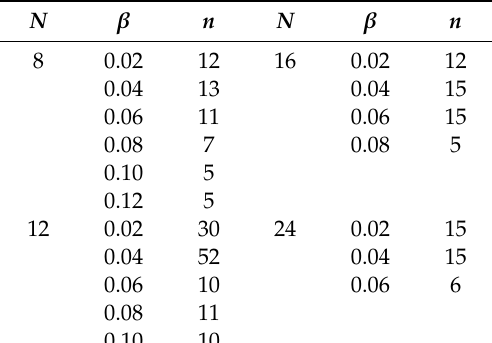
Table 3. Values for the number of base functions chosen for each aspect ratio β .